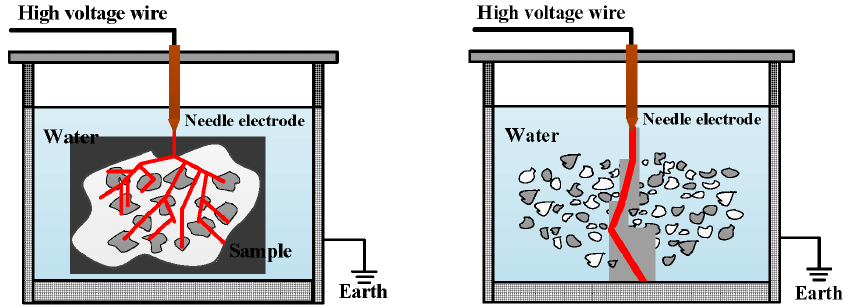
Figure 1. Schematic diagram of showing the disintegration of solid particles by high-voltage electrical pulses.